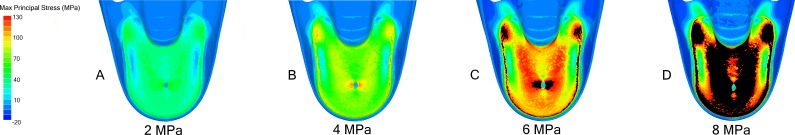
FEA results in Nautilus pompilius under increasing hydrostatic pressure.Development of max. principal stress on the final septum of N. pompilius under increasing (2 (A), 4 (B), 6 (C), and 8 (D) MPa) hydrostatic pressure. The results of these models are graphically illustrated in Fig. 2B. The region of septal attachment to the shell wall and the regions immediately lateral to the siphuncular foramen are the weakest regions in this model.